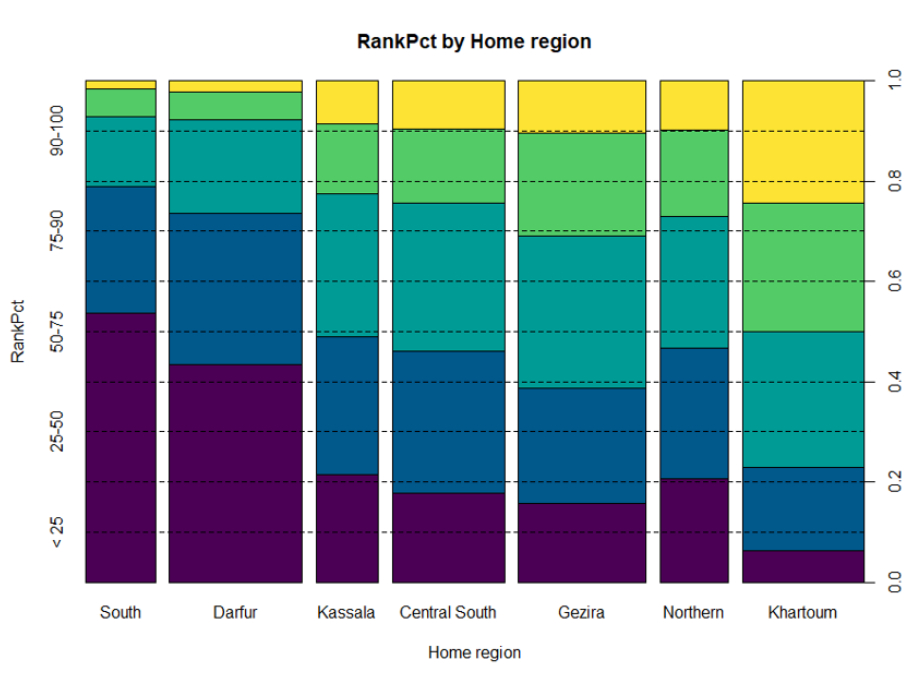
Figure 14. Academic rank by home region, incoming 2016–2017 bachelor’s students.